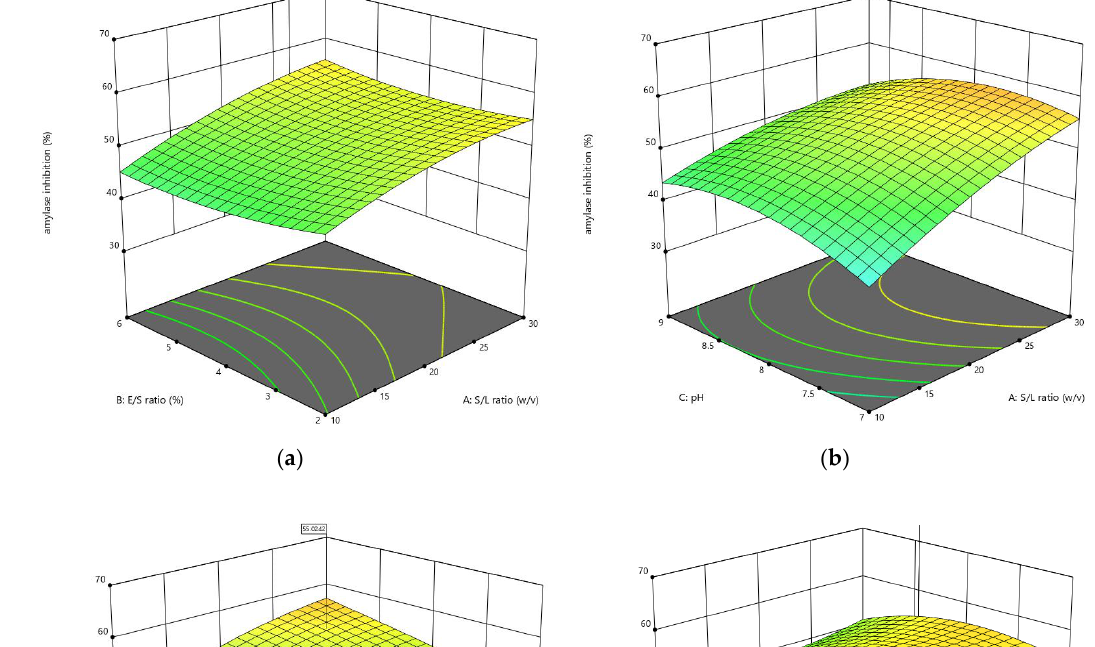
Figure 2. 3D response surface plots showing the influence of variable parameters on DH response using trypsin: ( a ) E/S ratio vs. S/L ratio, ( b ) pH vs. S/L ratio, ( c ) temperature vs. S/L ratio, ( d ) pH vs. E/S ratio, ( e ) temperature vs. S/L ratio and ( f ) temperature vs. pH.